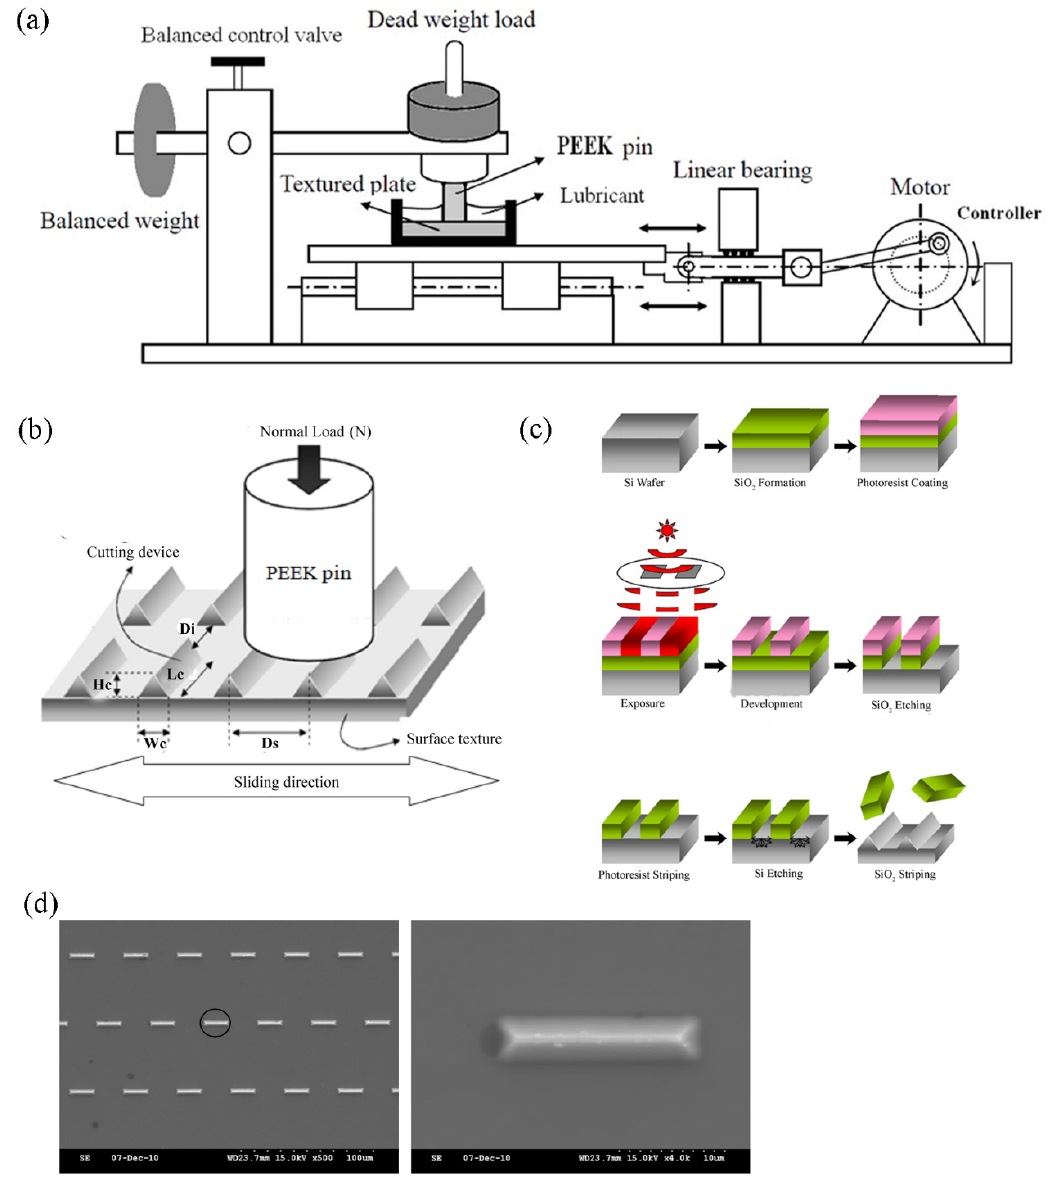
Figure 1. SEM images of the microfabricated surfaces. ( a ) Schematic of the setup for linear reciprocating wear testing. ( b ) Schematic of the particle generation in which microfabricated surface texture is rubbed against PEEK pin. Di: distance between adjacent features. Ds: pitch in the sliding direction. Lc: cutting-edge length. Wc: cutting-edge width. Hc: cutting-edge height. ( c ) Illustration of microfabricated surface textures process. ( d ) The wedges used in this study are 5 µ m in width and 20 µ m in length. The texture in the black circle is magnified on the right.